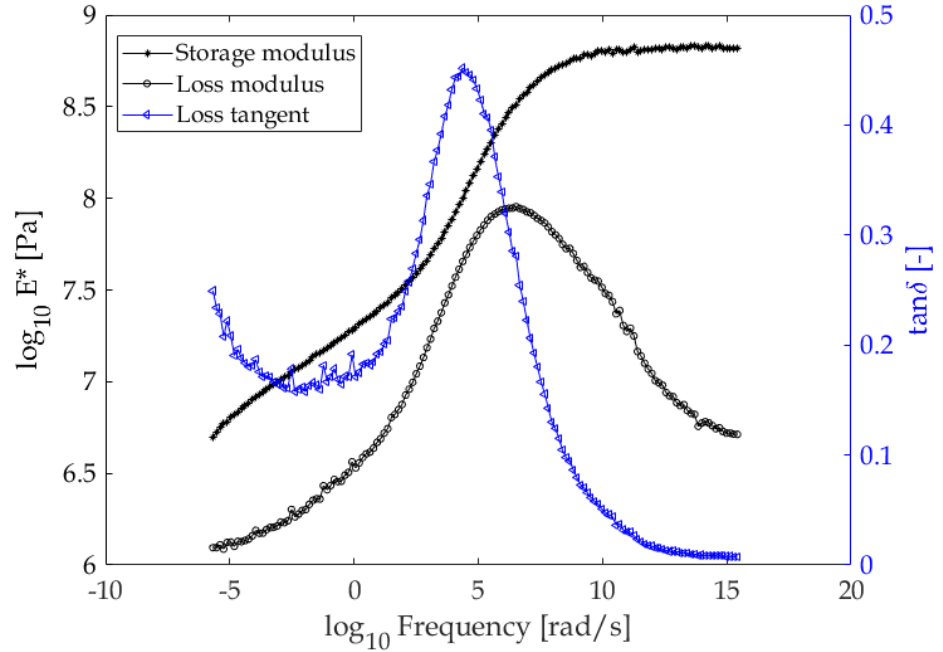
Figure 3. A typical complex modulus of a tyre. DMA material testing was commissioned by the authors for a tread rubber